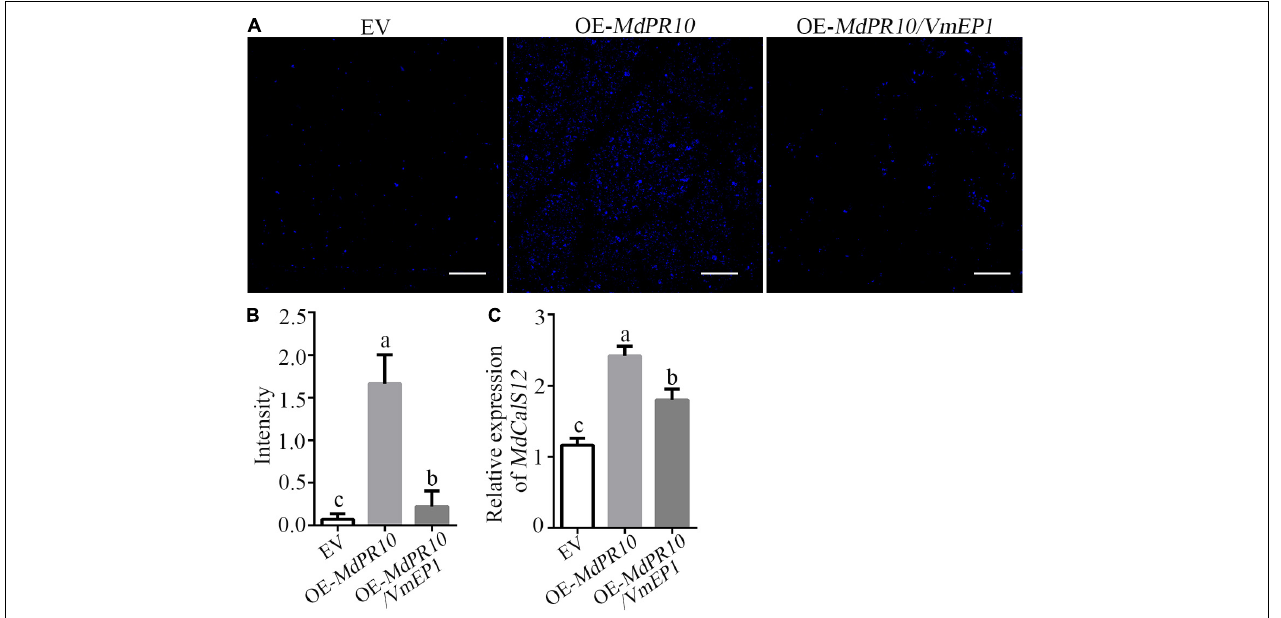
FIGURE 4 | A Valsa mali effector protein 1 suppresses MdPR10 -mediated callose deposition. (A) Aniline blue staining with leaves at 48 h after expression of MdPR10 or co-expression of MdPR10 and VmEP1 in the apple leaves. Bars = 100 µ m. The expression of EV as control. Bars = 50 µ m. (B) Quantification of the callose deposition in apple leaf tissues, as determined by ImageJ software. Mean ± SD; n > 10; a, b, and c indicate t-test P < 0.05; Duncan’s multiple range test. (C) The mRNA level of MdCalS5 in the apple plantlets, as revealed by qRT-PCR 2 days after infiltration of OE- MdPR10 . The transcript levels were analyzed